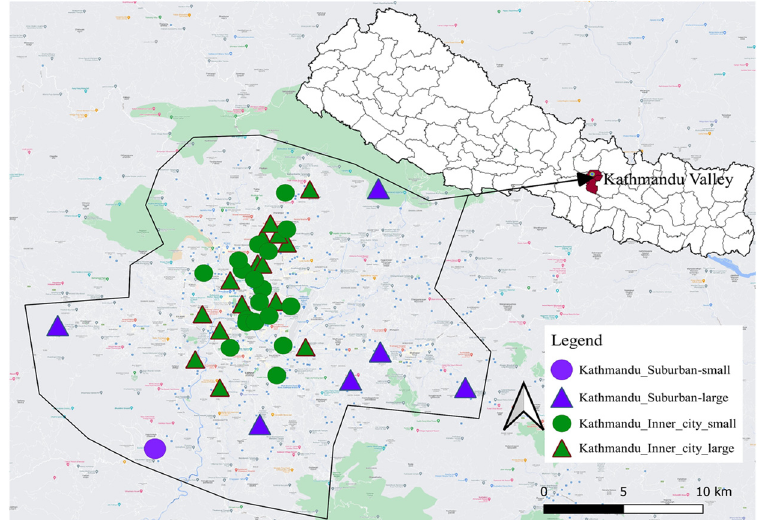
Figure 2. Map of the location of 40 assumed UA production sites in Kathmandu Valley, Nepal. Background image courtesy of Google Maps, image generated using QGIS.